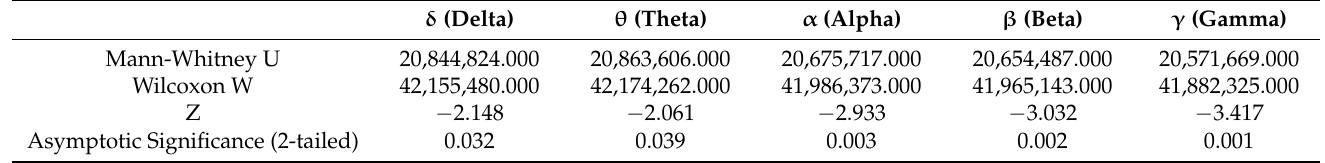
Table A7. Test Statistics for Mann-Whitney U Tests conducted on the Balance